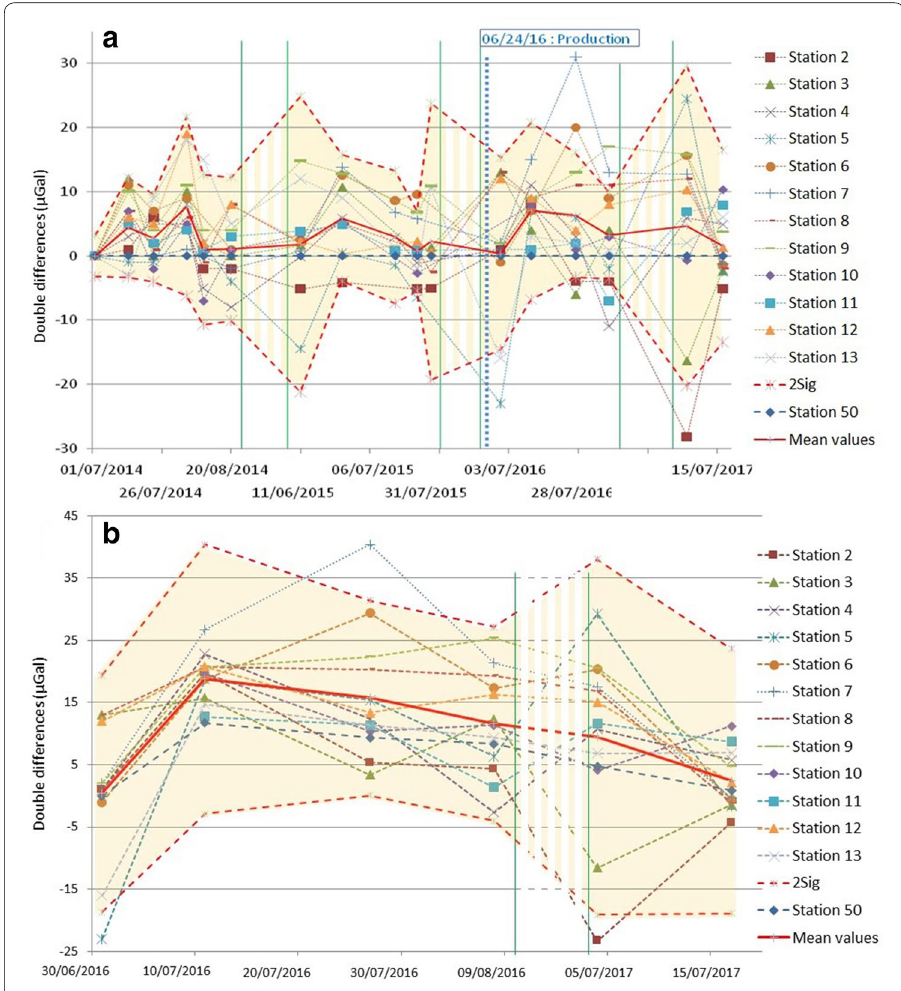
Fig. 10 Soultz‑sous‑Forêts gravity double differences in µGal. 95% confidence interval is highlighted in yellow and is centered on the mean survey value (red line). a We do not consider the gravity changes at the reference station 50 (blue dotted line); b accounting for